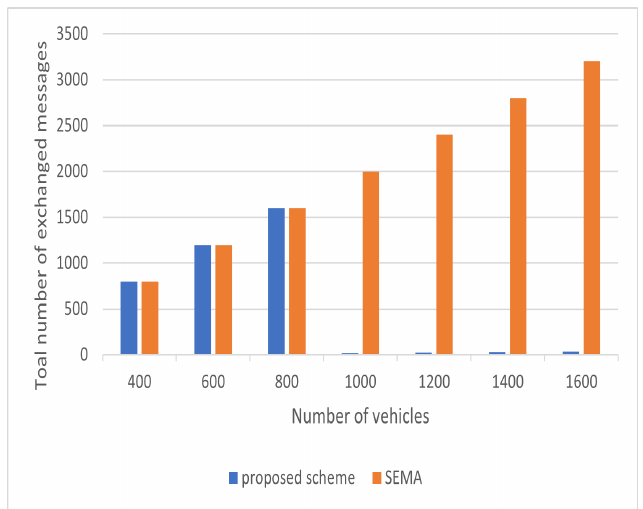
Figure 2. Communication overhead